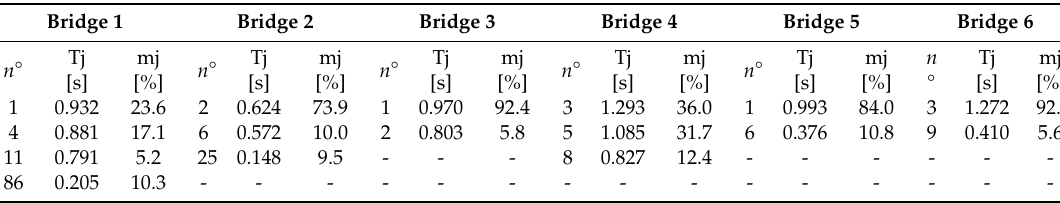
Table 3. Longitudinal vibration modes.